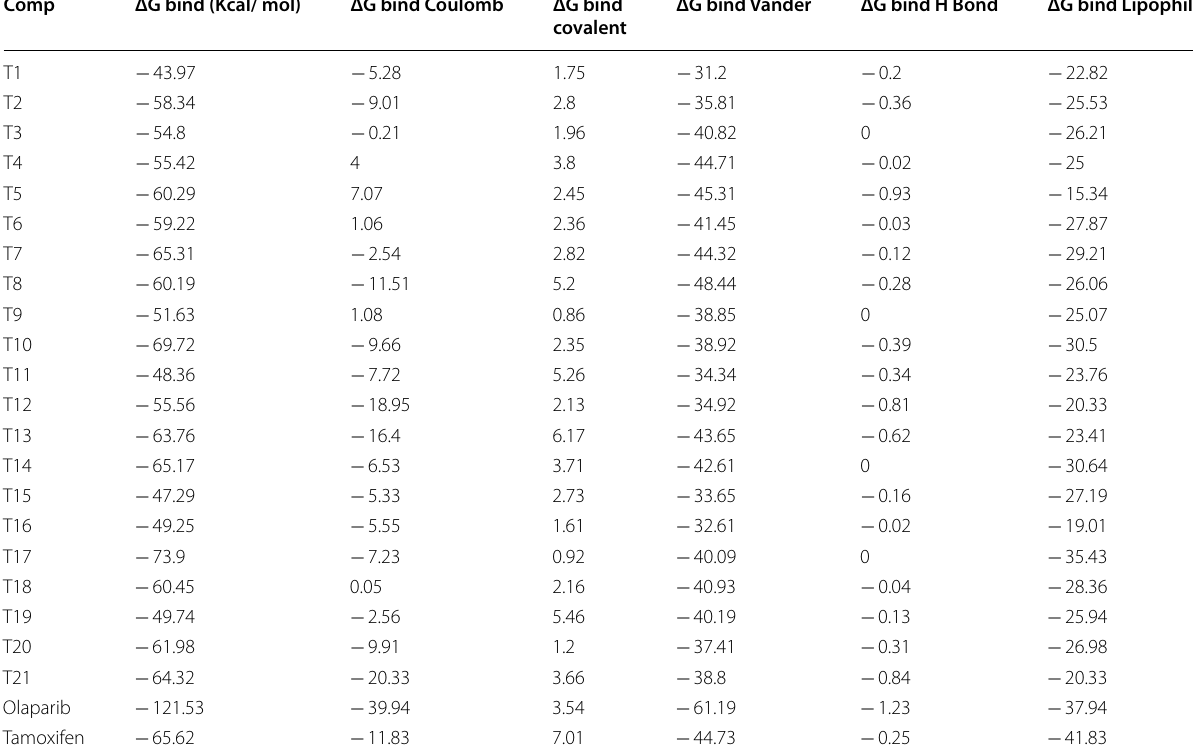
Δ G bind, free energy of binding; ΔG bind Coulomb, Coulomb energy; ΔG bind covalent, covalent energy (internal energy); ΔG bind Vander, van der Waals energy; ΔG bind H Bond, hydrogen bonding energy; ΔG bind Lipophilic, hydrophobic energy (non-polar contribution estimated by solvent accessible surface